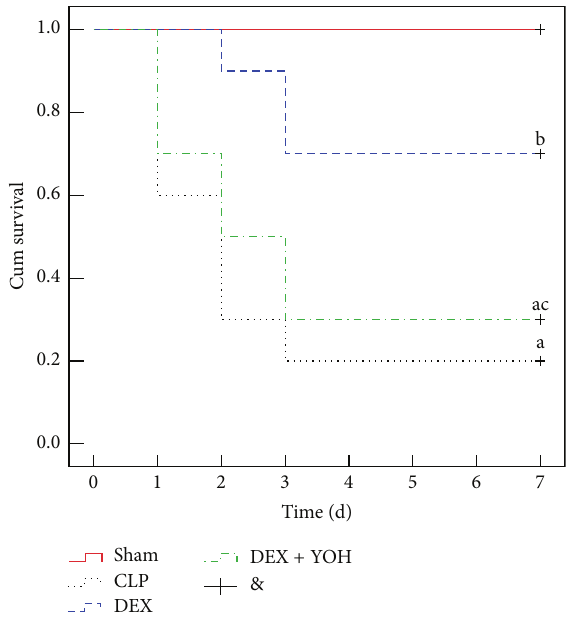
Figure 1: DEX treatment improved the survival of CLP-induced septic rats. Kaplan–Meier survival curves for four groups of rats 7 d ( 𝑛 = 10 ). a 𝑃 < 0.05 , versus Sham group; b 𝑃 < 0.05 , versus CLP group; c 𝑃 < 0.05 , versus DEX